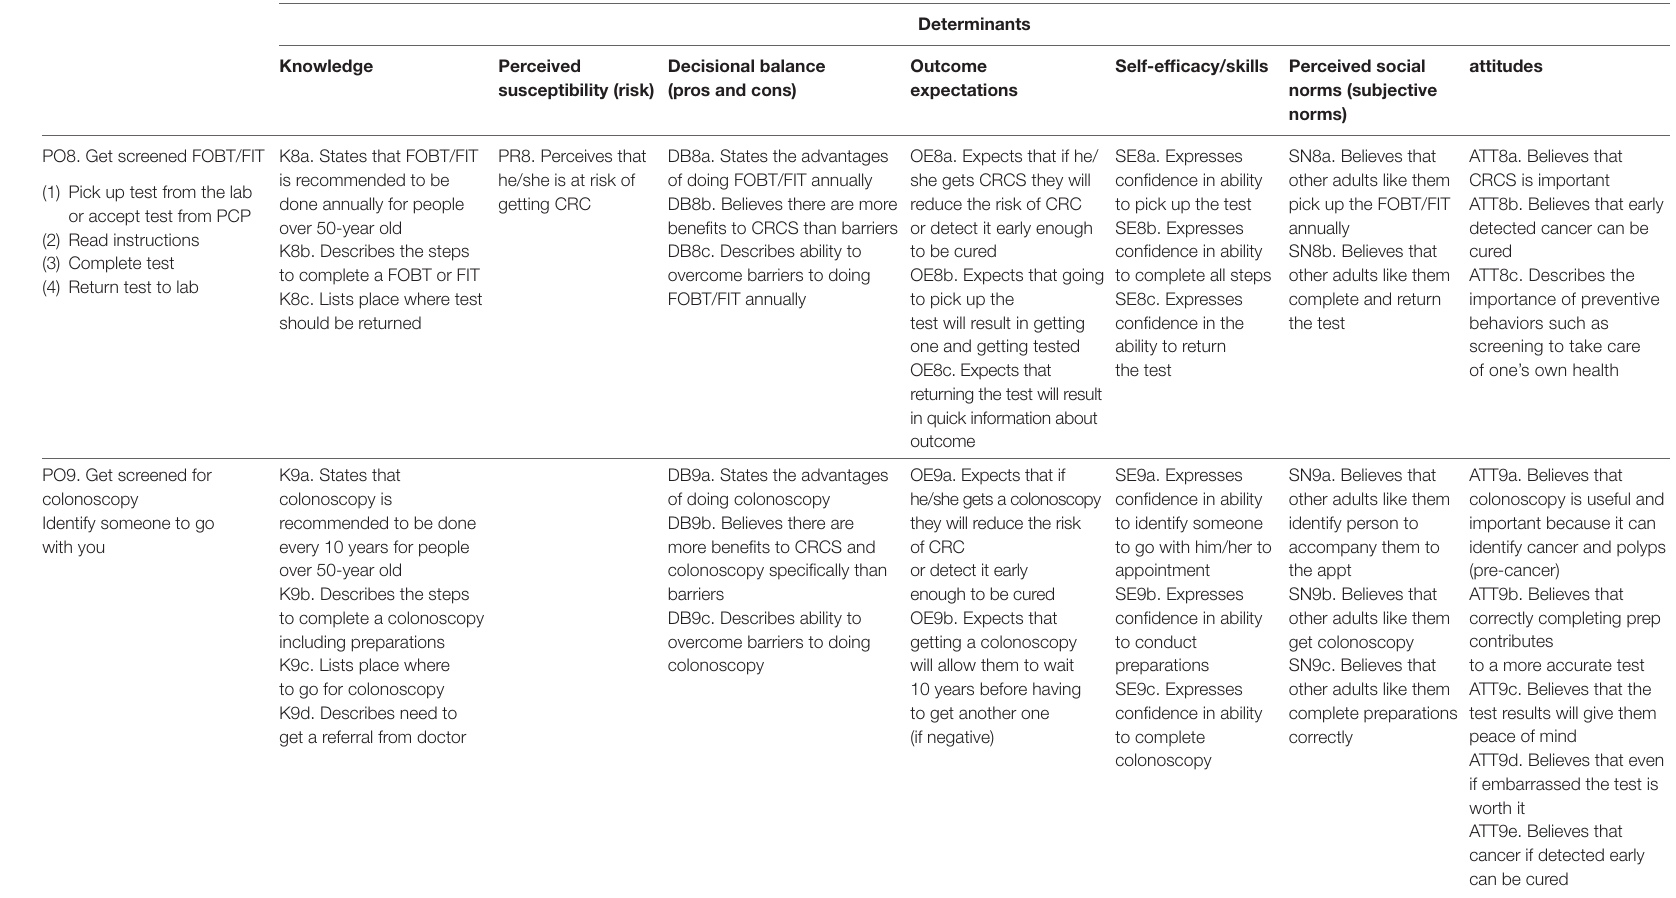
table 4 | Sample cells from matrix of change